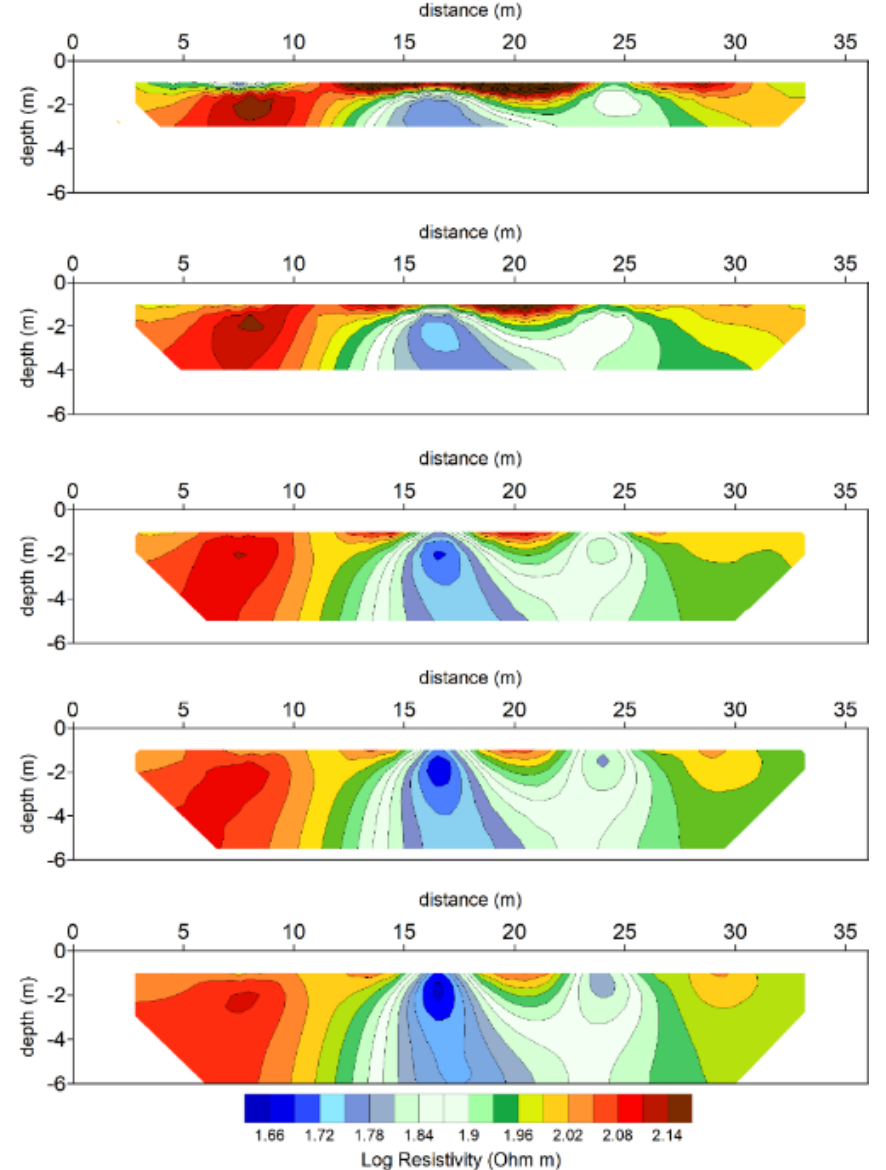
Figure 5. Extractions of the N q tests in depth (from top to bottom k = 5, k = 7, k = 9, k = 10) and estimation of ρ m with linear best-fit procedure (last section).